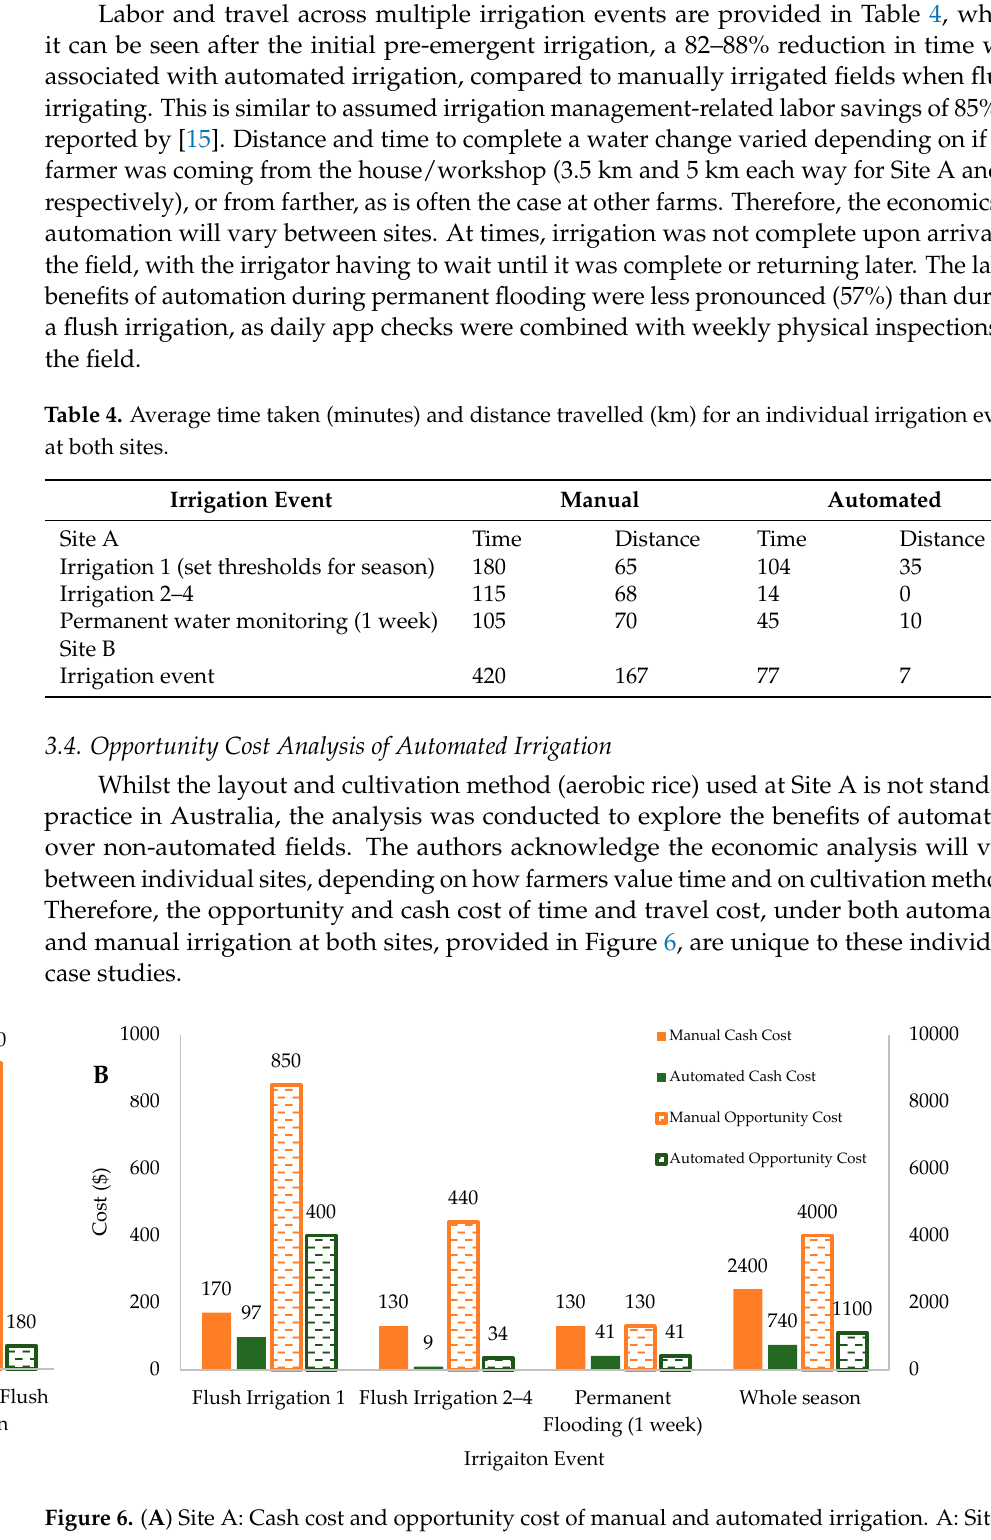
Figure 6. ( A ) Site A: Cash cost and opportunity cost of manual and automated irrigation. A: Site A, for one flush-irrigation event across the nine-bay field on the left axis. ( B ) Site B, flush irrigation 1, flush irrigations 2–4 and 1 week of daily check during permanent flooding on the middle axis; the seasonal data is provided on the far-right axis.